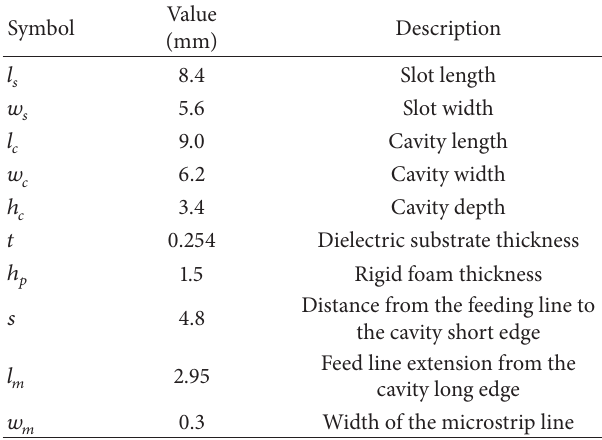
Table 1: Geometrical parameters of the slant polarized IMF-CBSA